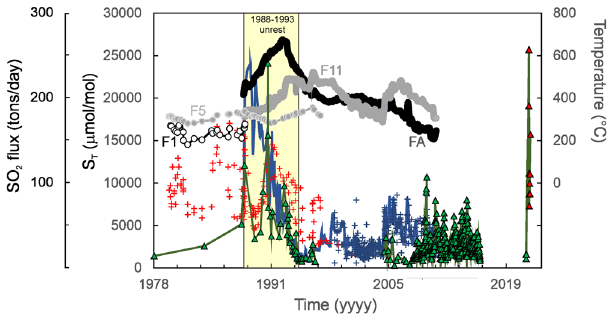
Fig. 5 Chronology of sulphur release from La Fossa crater. A review of literature data on fumarole temperatures, SO 2 fl uxes, and fumarole total S content (S T ). SO 2 fl ux results (triangles) are from same source as Fig. 2. Data from this study (Supplementary Table 1) are identi fi ed by red bordered triangles. Total S content (S T ) in directly sampled fumaroles (red crosses, refs. 19,36,40 ; solid blue line, ref. 34 ; blue crosses, ref. 23 ). Fumarole temperatures are from ref. 19,36 (circles, F1 and F5 fumaroles) and from ref. 34 (FA and F11 fumaroles). A clear temporal shift is observed between the peak in sulphur release (both SO 2 fl uxes and S T ) and the temperature peak (the latter lagging behind >2 years in